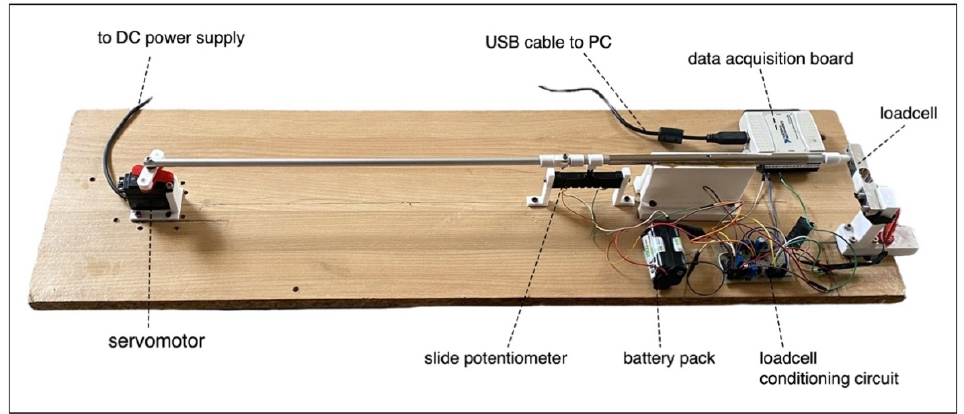
Figure 3. Prototype of the realized electromechanical system for testing force sensors.